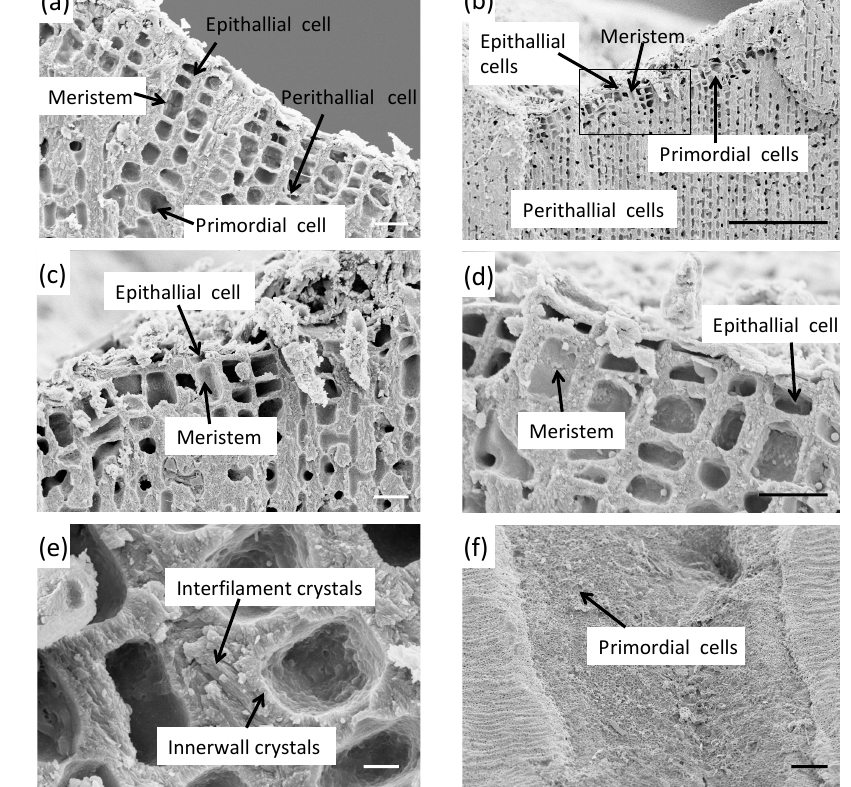
Figure 10. Examples of wound recovery during dark calcification. (a) Wound tissue recovery after 2 months in dark conditions. Primordial cells, perithallial cells, meristem cells and two to three epithallial cells appear similar to those shown in Fig. 9a–c for lighted wound recovery tissues (ClEx 71 4dk). (b) Similar wound recovery after 1 month of growth in the dark. There are fewer cells, with only few meristem cells apparent as compared to (a) ; rectangle indicates area magnified in (c) (ClEx 31 4dk). (c) Magnification section of (b) showing three meristem and two new epithallial cells being initiated (ClEx 31 4dk). (d) Section of 1-month dark groove developing new tissues. Meristem cells are in process of developing along with one or two epithallial cells. Note clear development of interfilament, even at this early stage, along with standard radial inner-wall crystals (ClEx 41 4dk). (e) Normal upper perithallial tissue from 4 ◦ C tank after 2 months of dark growth (meristem cell in upper left) showing extensive, normal diagonal interfilament crystals developed in the dark (ClEx 71 4dk). (f) Surface view of part of scar made on 1 May 2013, when specimen was placed in dark chamber of 4 ◦ C tank. Collected on 1 July 2013, large cells visible on mid-slope lateral surfaces of scar are recovering primordial cells. Lateral to groove, on normal tissue, right and left, overlying epithallial tissue can be seen to be heavily grazed by chitons in form of en-echelon, fine grooves (ClEx 71 4dk). Scale bars: 2µm (e) , 10µm (a, c, d) , and 100µm (b, f)